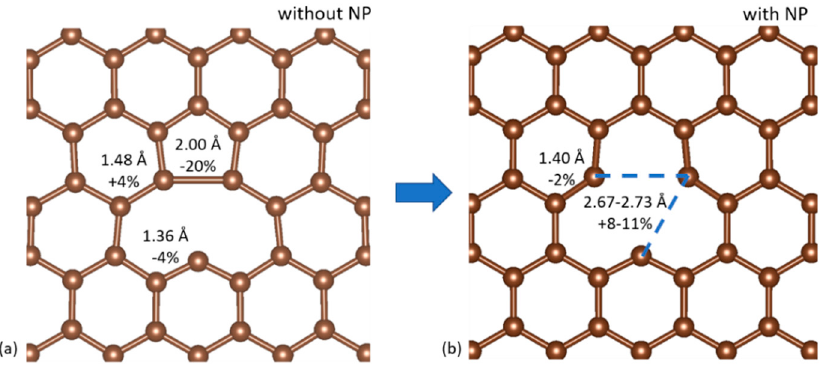
Figure 3. ( a ) The Jahn–Teller distortion of graphene vacancies and ( b ) its removal caused by the presence of the NP vertex. The bond lengths and their relative change compared to pristine graphene are noted.